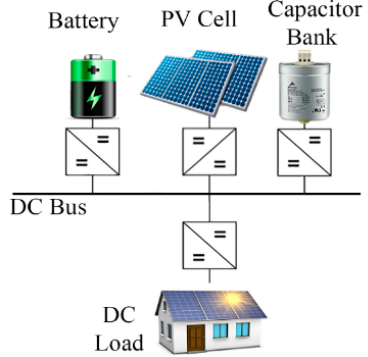
Figure 1. Schematic structure of photovoltaics (PV)-battery islanded dc microgrids.